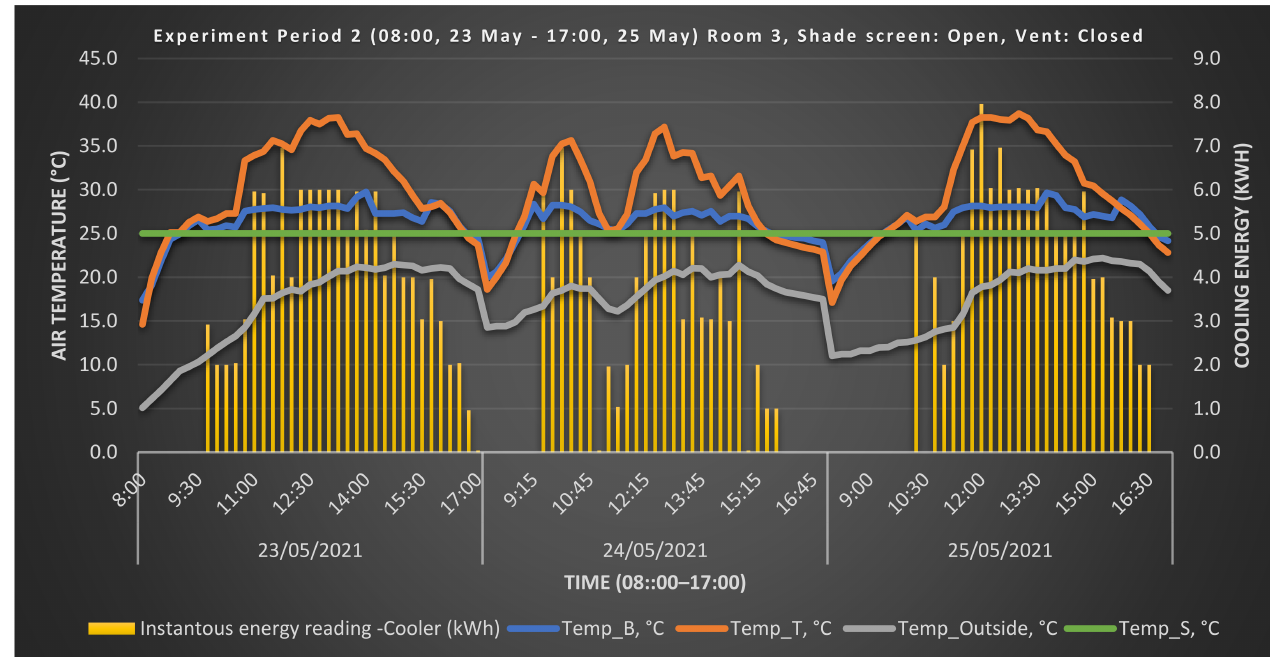
Figure 3. Temperature and energy use in different vent and shade screen status in experimental Period 2. Air temperatures ( ◦ C) collected at the base (B), top (T), and outside are depicted in blue, orange, and white lines, respectively. Energy use (kWh) measured by mechanical coolers is depicted over time using yellow bars along with air